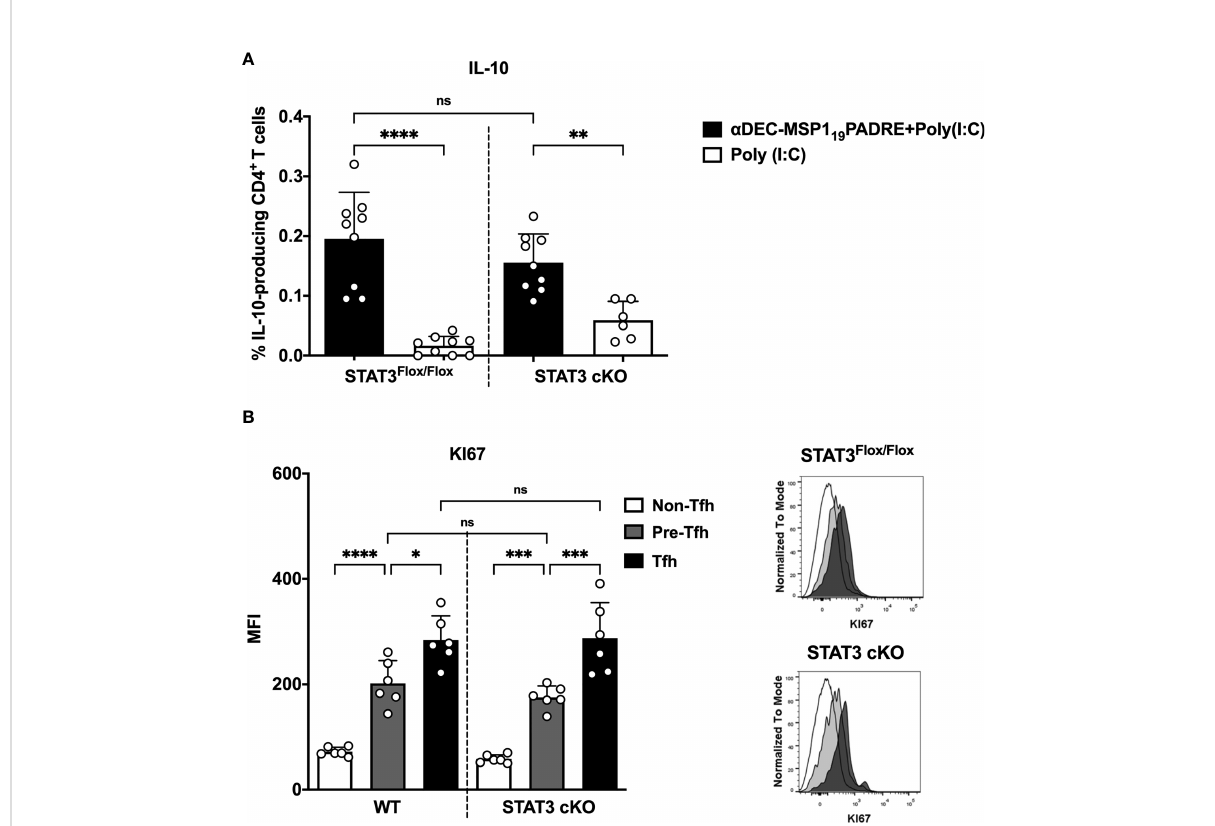
FIGURE 5 IL-10 production by CD4 + T cells is not in fl uenced by STAT3 signaling pathway in cDC1 after antigen targeting to the DEC205 receptor. STAT3 Flox/Flox and STAT3 cKO mice were immunized as described in Figure 3. Splenocytes were obtained 4 days after boosting. (A) Intracellular cytokine staining for IL-10. Plots show the percentage of IL-10-producing CD4 + T cells. (B) Intracellular staining of Ki67 in Tfh, pre-Tfh and non-Tfh cells cells performed by fl ow cytometry in spleen cells 4 days after immunization. Histograms represent non-Tfh cells in white, pre-Tfh cells in gray and Tfh cells in black. Bars show mean ± SD from three experiments pooled together (n=9 animals/group, except STAT3cKO immunized with poly(I:C), n=6 animals/group) in (A) , and two experiments pooled together (n=6 animals/group) in (B) *p<0.05, **p<0.01, ***p<0.001, ****p<0.0001, and ns not signi fi cant; one-way ANOVA followed by Tukey ’ s